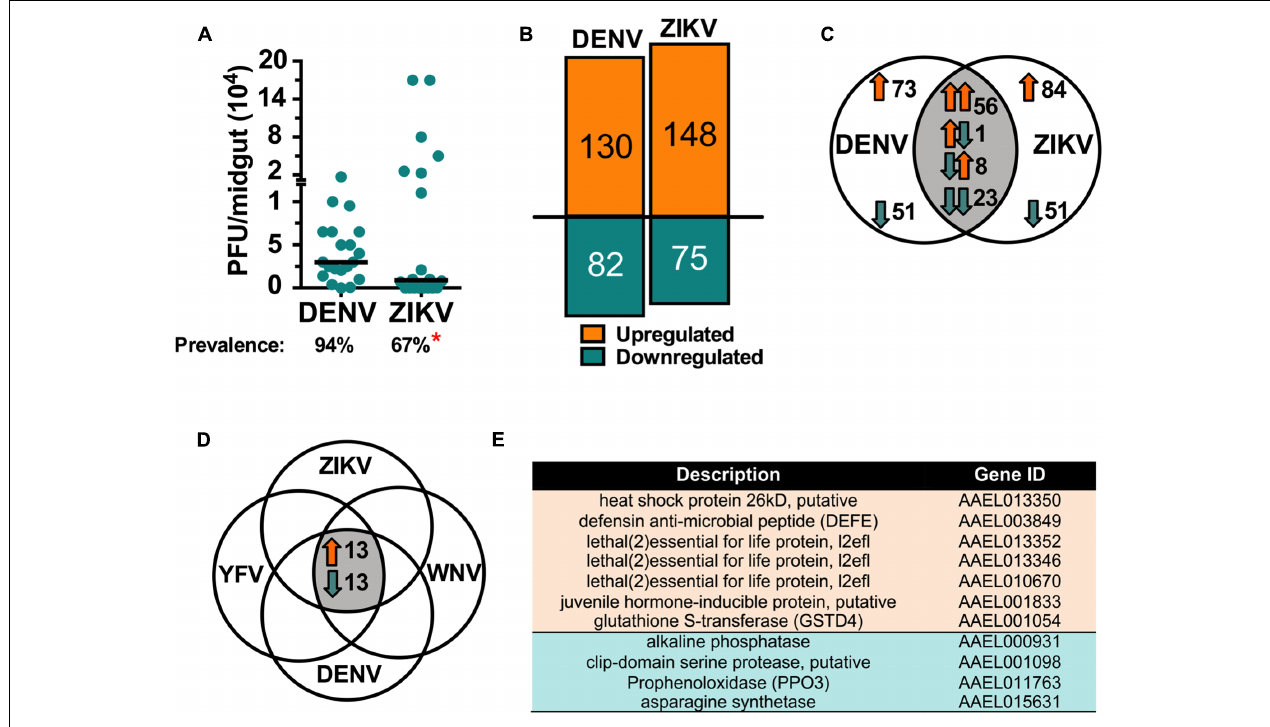
FIGURE 2 | Comparative transcriptomic analysis of A. aegypti responses to ZIKV and DENV infection. RNA-seq analysis was performed on ZIKV- and DENV-infected Rock A. aegypti midguts at 7 dpibm. (A) PFU per midgut; bars represent the median for three independent experiments ( N = 20). The prevalence (percentage) is shown below the graph, ∗ P < 0.05; chi square test. (B) Total up- and downregulated genes. (C) Venn diagram showing the shared and uniquely regulated genes in ZIKV vs. DENV infected mosquitoes. (D) Venn diagram showing genes regulated in the same direction upon infection with YFV, WNV, DENV, or ZIKV (Colpitts et al., 2011). (E) List of the identified mosquito genes with known function (11 of 26): upregulated genes shown in orange, downregulated in blue. Upregulated genes with unknown function (AAEL004157, AAEL006305, AAEL000586, AAEL005986, AAEL009058, AAEL011110) and downregulated genes with unknown function (AAEL012644, AAEL009181, AAEL002046, AAEL007703, AAEL013812, AAEL002889, AAEL004022, AAEL008106,